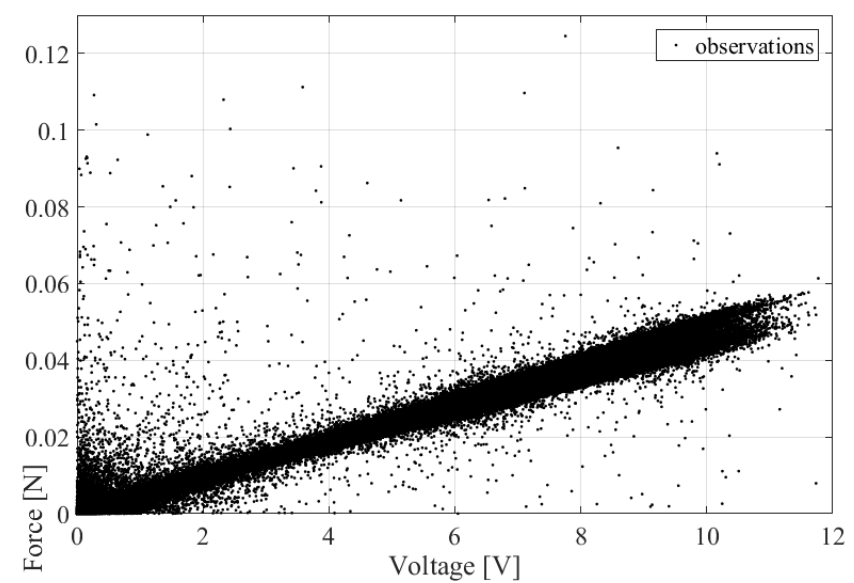
Figure 2. Measured voltage versus corresponding force for energy harvester.